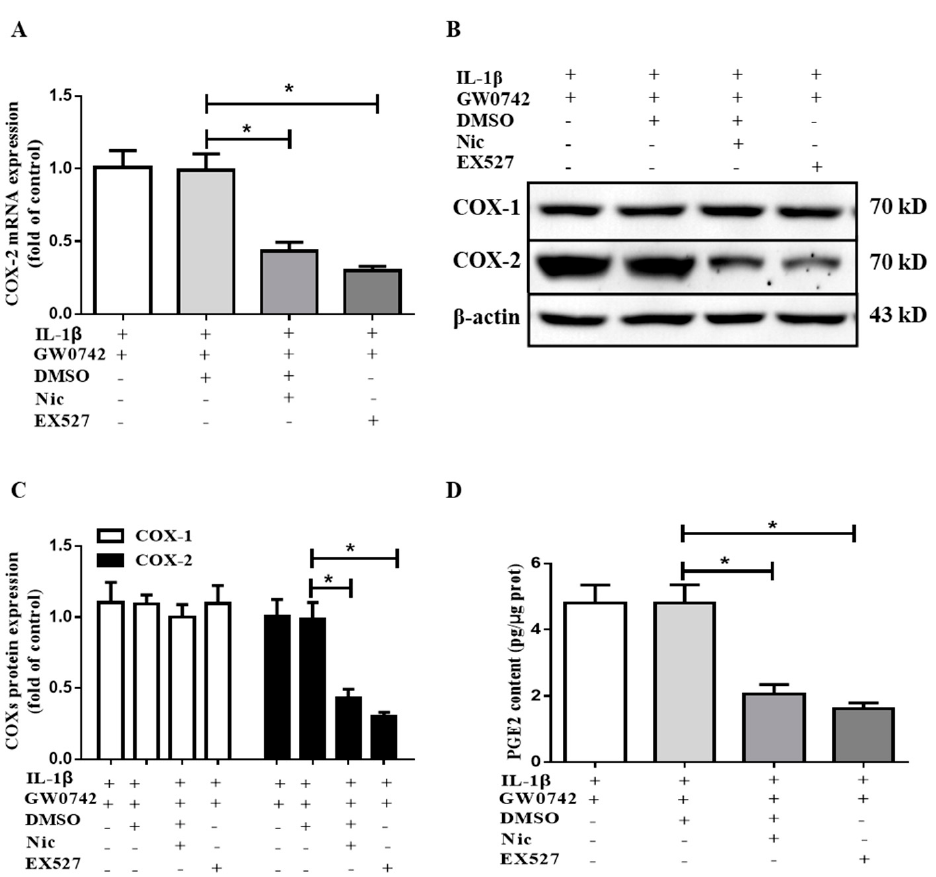
Figure 6. SIRT1 inhibition blocks the stimulatory effect of PPAR β / δ on IL-1 β -induced COX-2 expression and PGE2 production in human mesangial cells. The cells were pretreated with GW0742 (1 µ M) in the presence or absence of the SIRT1 inhibitors NIC (niconinamide, 5 mM) or EX527 (1 µ M) for 6 h, followed by treatment with IL-1 β (5 ng/mL) for 12 h. ( A ) The SIRT1 inhibition significantly attenuated the stimulatory effect of PPAR β / δ on the IL-1 β -induced COX-2 expression. The expression of COX-2 mRNA was analyzed with real-time PCR. ( B , C ) A Western blot assay showed that SIRT1 inhibition blocked the stimulatory effect of PPAR β / δ on the IL-1 β -induced COX-2 protein expression with little effect on COX-1. ( D ) The effect of SIRT1 inhibition on PGE2 production. * p < 0.05 vs. IL-1 β + GW0742 + DMSO; n =